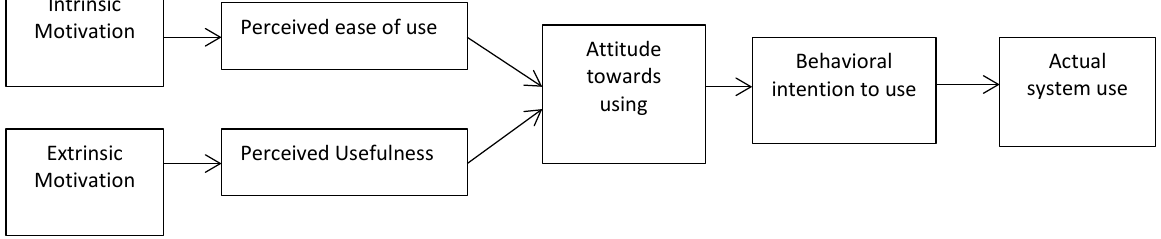
Figure 2. Effect of motivation on the technology acceptance model (TAM).